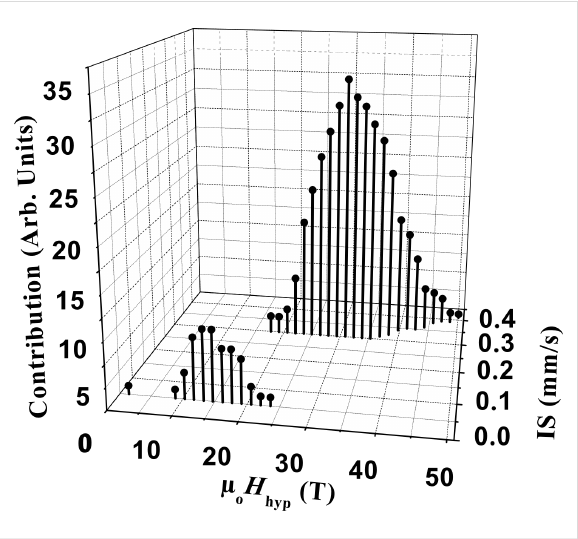
Figure 5: Distributions of the IS and the µ 0 H hyp used to fit the experi- mental Mössbauer spectrum measured at 5 K.